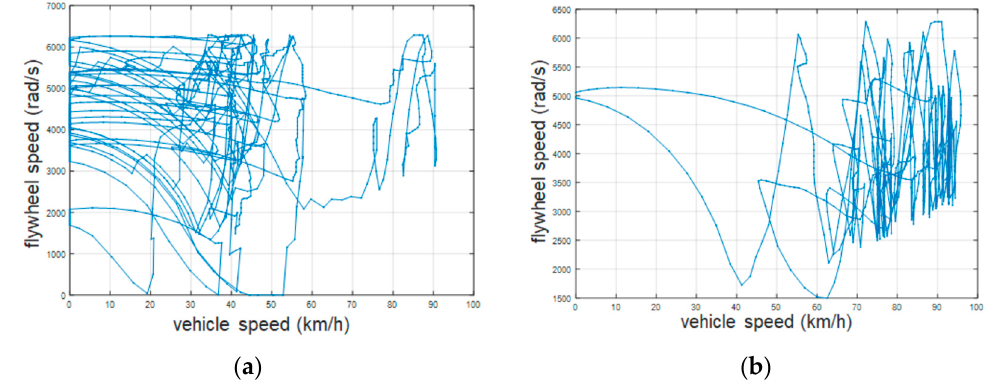
Figure 21. FESS speed versus vehicle speed: ( a ) UDDS driving cycle; and ( b ) HWFET driving cycle.